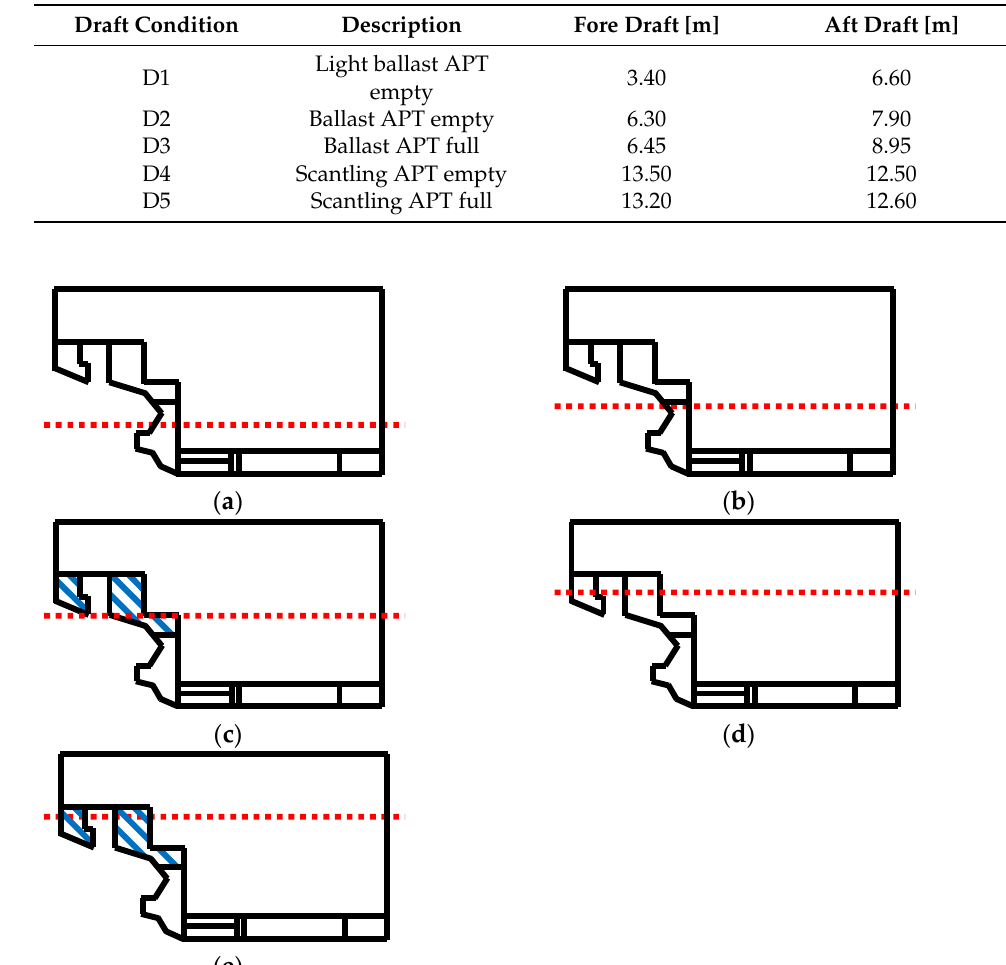
Figure 5. Stern draft according to measurement draft conditions: ( a ) D1, ( b ) D2, ( c ) D3, ( d ) D4, and ( e ) D5.